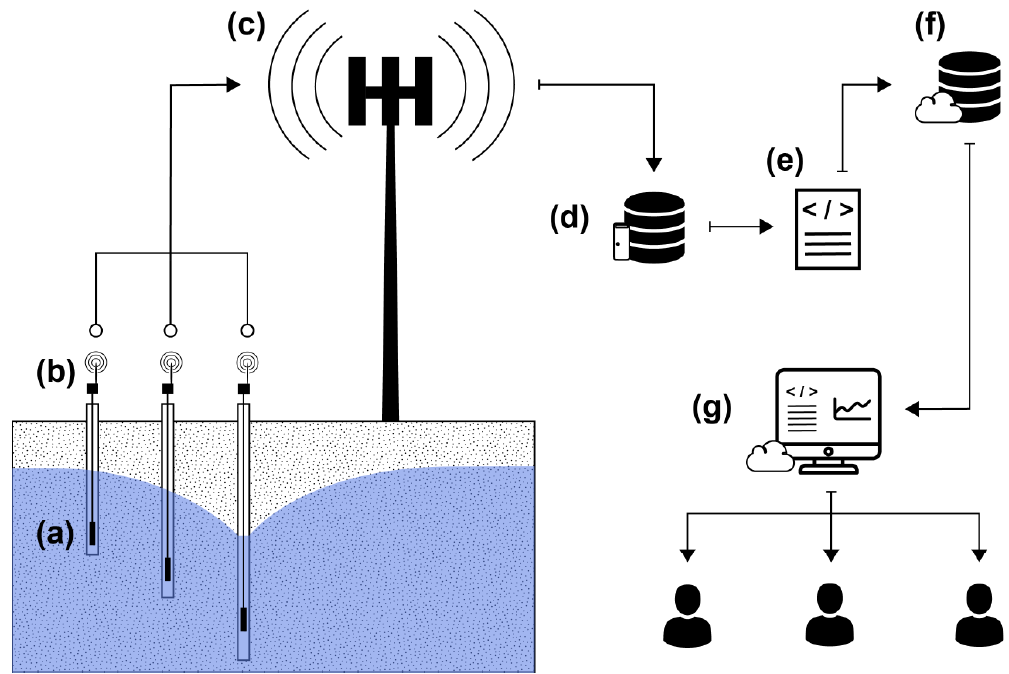
Figure 3. Each component of the GWO, labeled along the direction of data flow, ( a – g ). ( a ) Deployed sensors in monitoring wells collect groundwater level data at a specified monitoring frequency, ( b ) telemetry units located outside of the well housing send data at a specified reporting frequency, ( c ) cellular network that receives data sent via telemetry and forwards to the local server, ( d ) SQL database on local server, ( e ) local data processing scripts that automatically run on a task scheduler and push clean data to the cloud database, ( f ) cloud database for data backup and storage, ( g ) server that reads clean data from the cloud database and hosts the Shiny web dashboard.